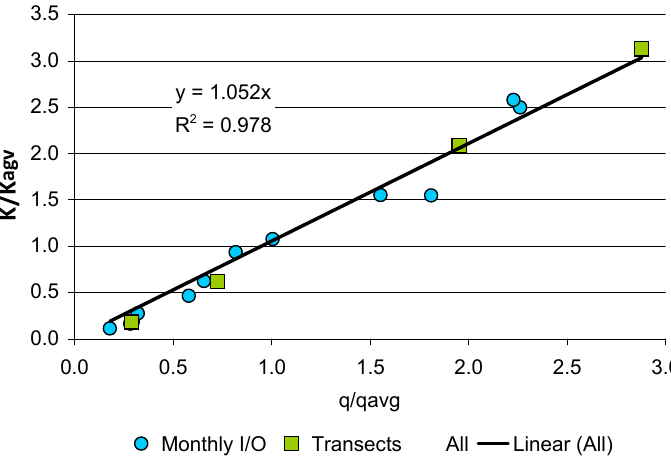
Figure 17. Relative monthly rate coefficients (K/Kavg) versus the relative hydraulic loading (q/qavg) for five STA wetlands. Also shown are four flow groups of transect rate coefficients for STA2C3. (q = hydraulic loading, cm/day).